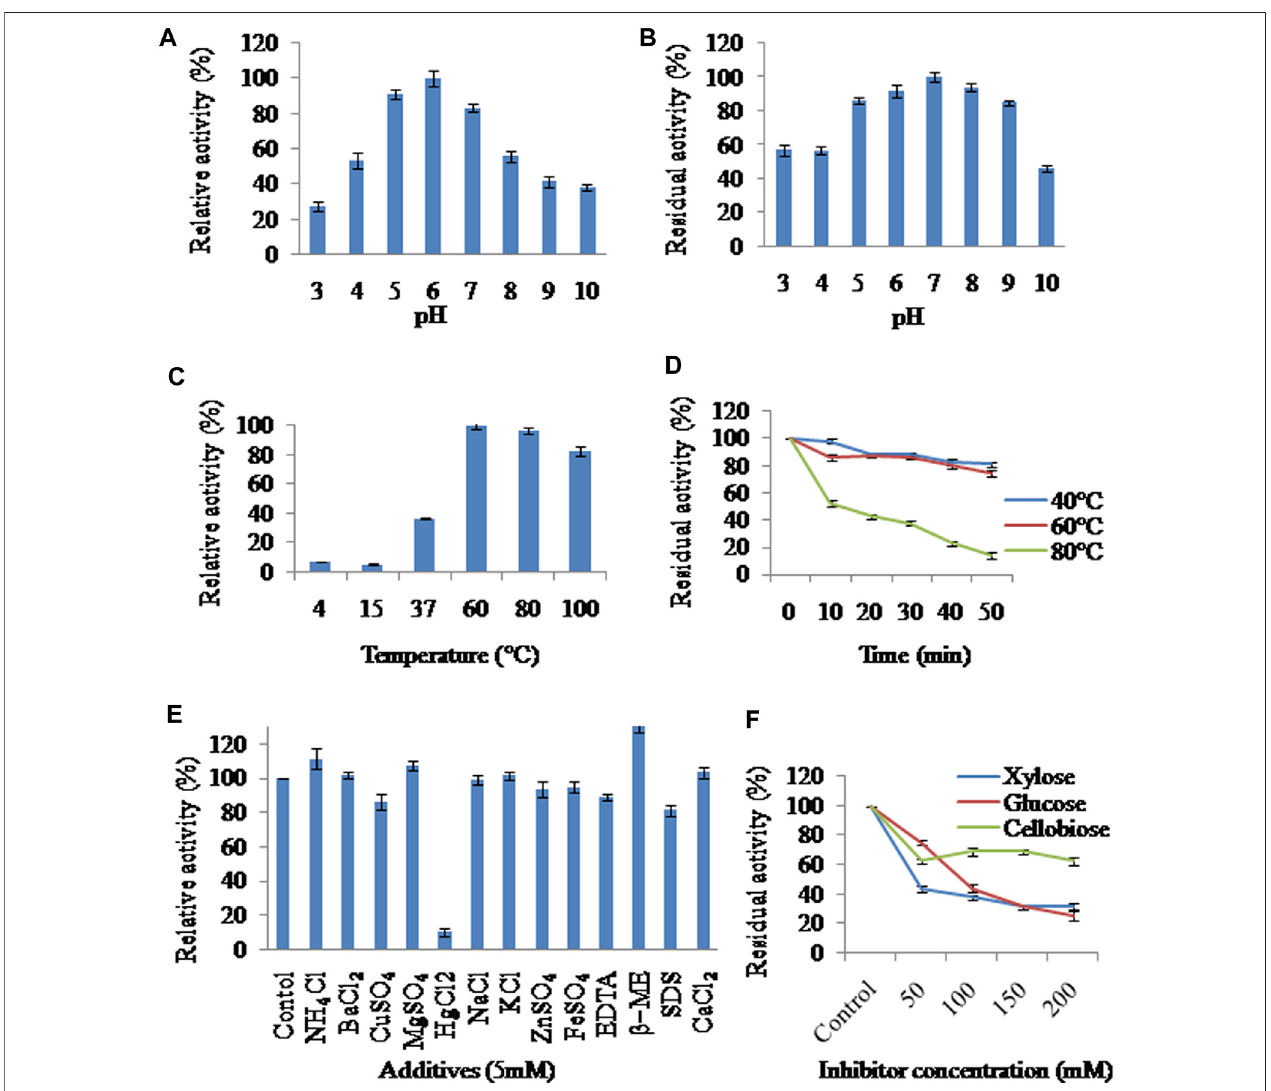
FIGURE 2 | Effect of (A) pH on activity (B) pH on stability (C) temperature on activity (D) temperature on stability (E) additives on activity (F) mono- and disaccharides on activity of xylanases present in XEP after 3 days of growth of RSC.